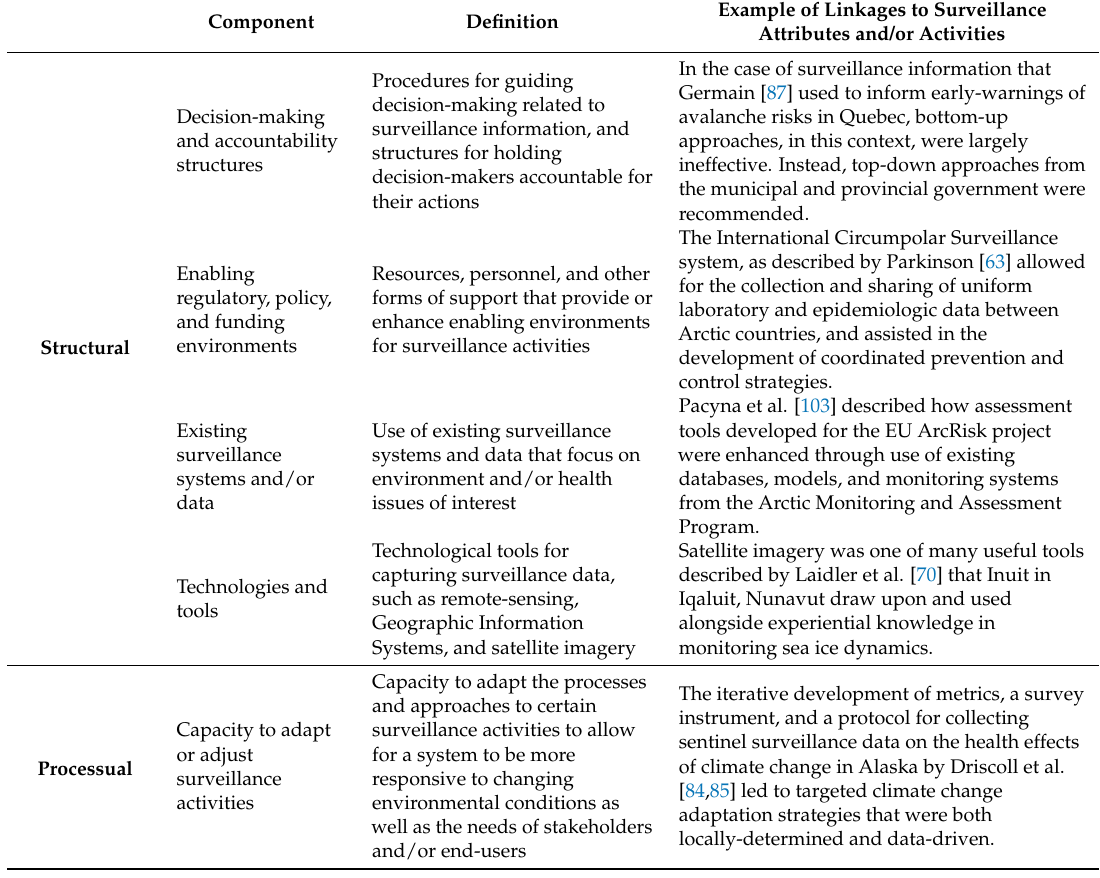
Table A5. Enabling components for integrated surveillance systems in Circumpolar Arctic and Subarctic regions as described or recommended by the